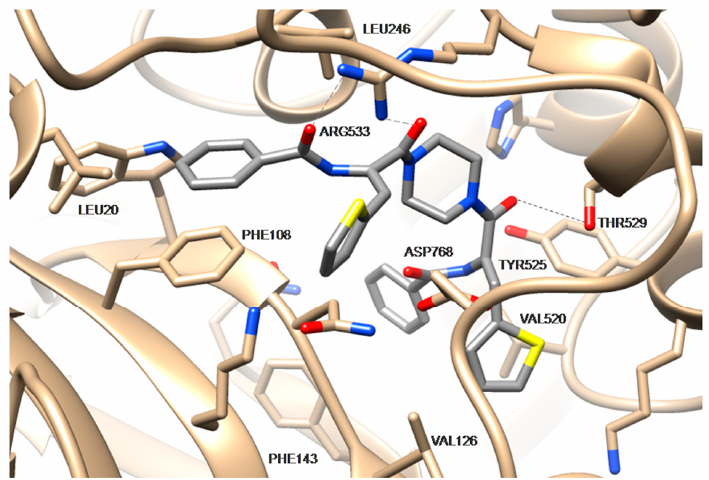
Figure 5. Preferred docking pose of 4c (depicted in grey) bound to soybean lipoxygenase (LOX-1).